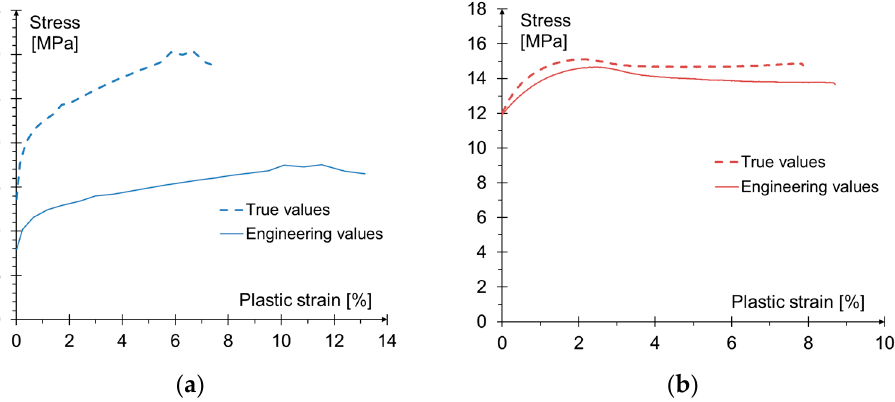
Figure 11. Comparison of engineering (from laboratory tests) and true values determined for: ( a ) shear stresses; ( b ) tensile stresses.